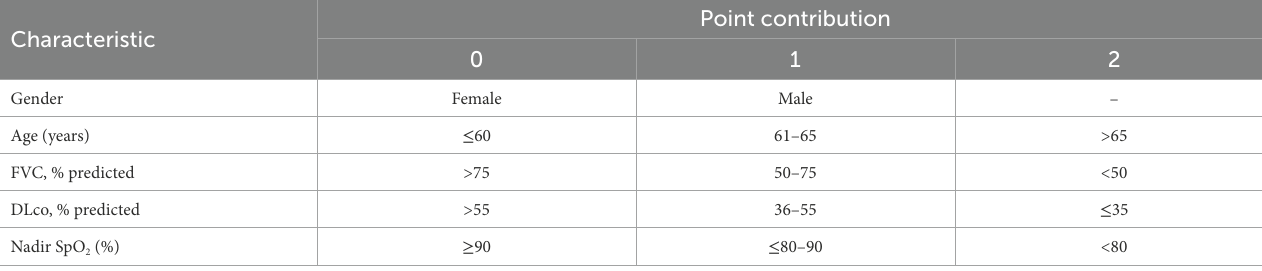
TABLE 4 Prognostic index based on presence of factors.